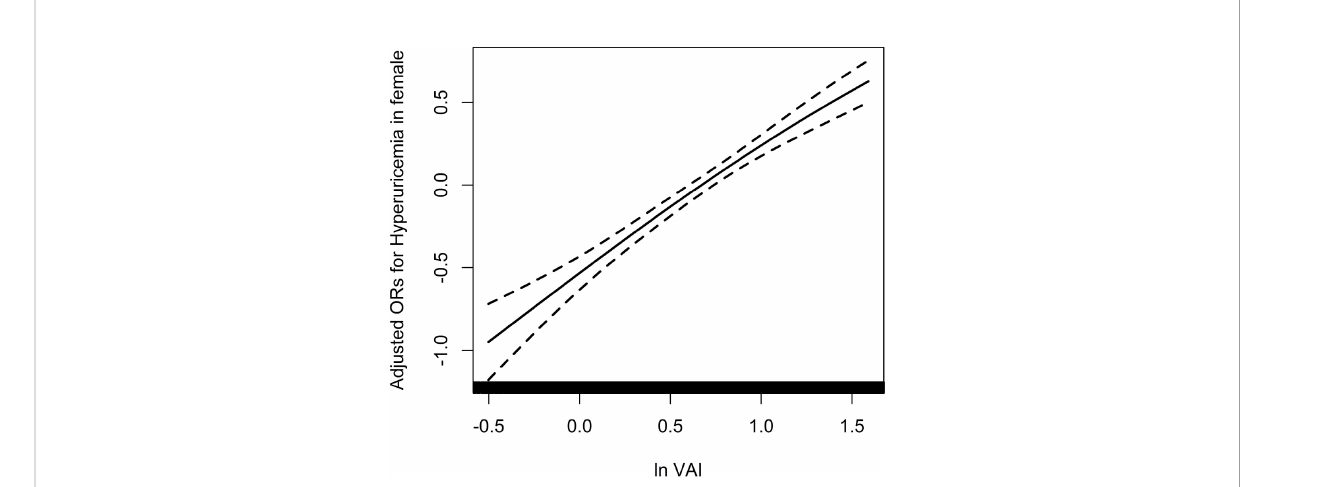
FIGURE 2 Association between ln VAI and hyperuricemia in females adjusted for age, smoking, drinking, BMI, SBP, DBP, TC, LDL-C, Hcy, eGFR, anti- hypertensive drugs, glucose-lowering